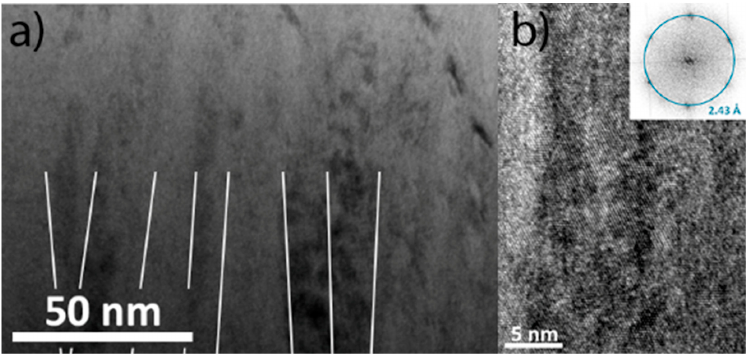
Figure 3. ( a ) TEM bright field (BF) image of the film deposited at 275 °C; ( b ) HR-TEM with Fast Fourier Transformation (FFT) inset. Transformation (FFT)